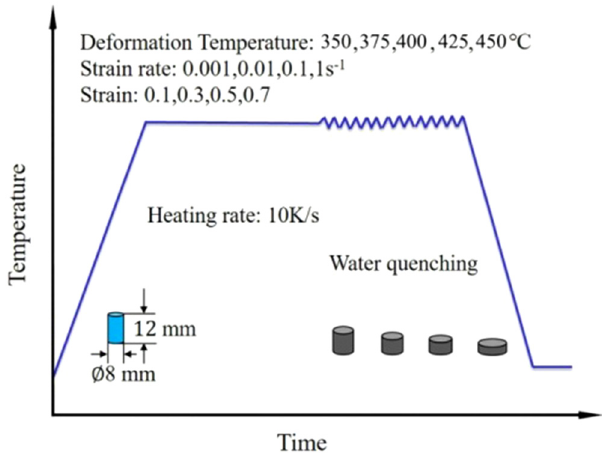
Fig. 1. Experimental procedure for hot